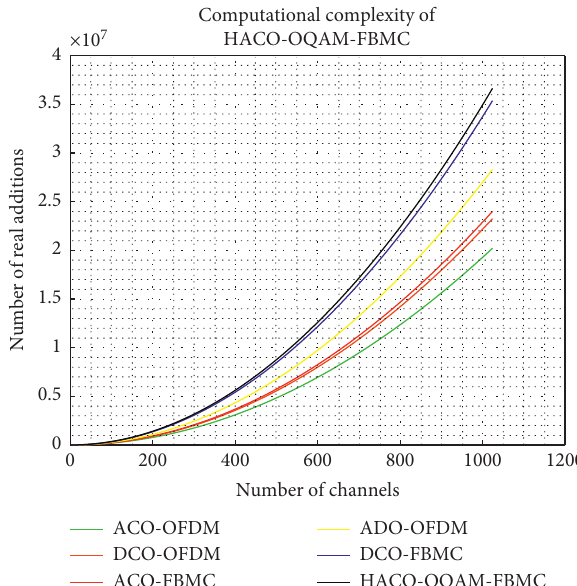
Figure 10: Simulation of computational complexity (additions) of ACO-OFDM, ACO-FBMC, DCO-OFDM, ADO-OFDM, DCO- OFDM, and HACO-OQAM-FBMC.